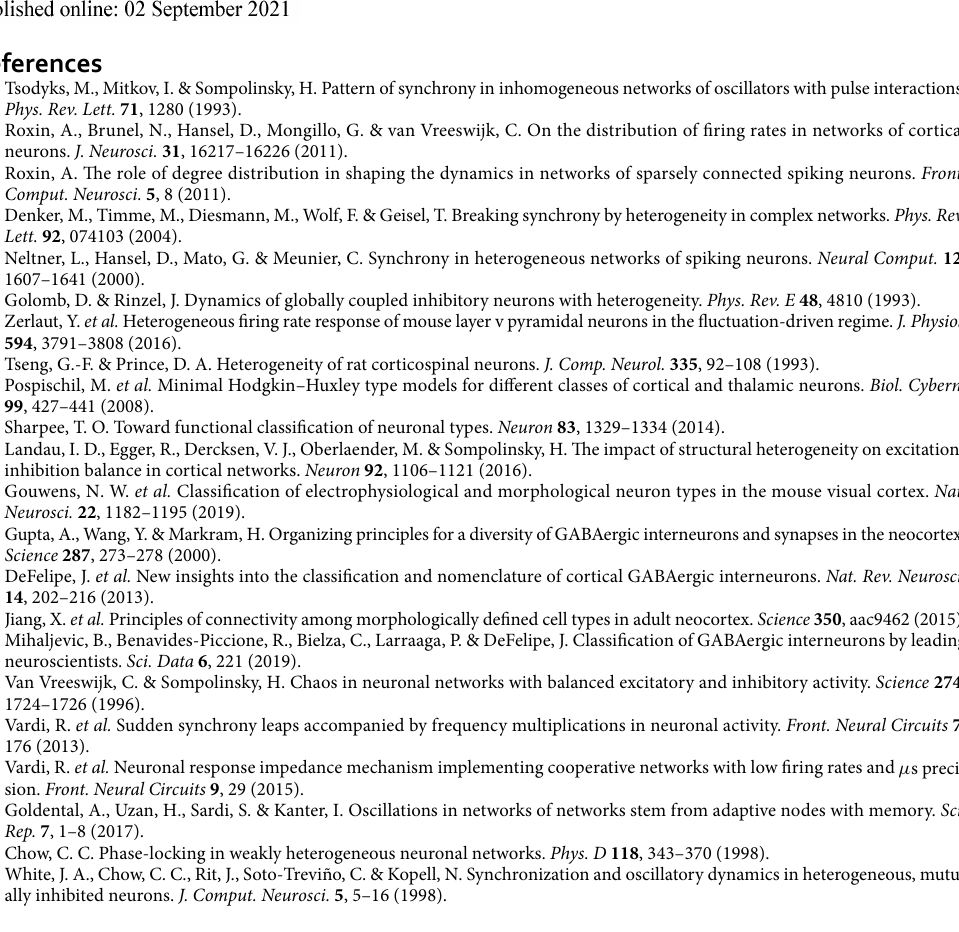
with T = 50 ms, (cid:31) inp = 1.5 mm , A = 1 Hz , t 0 = 100 ms and x 0 = y 0 = 10